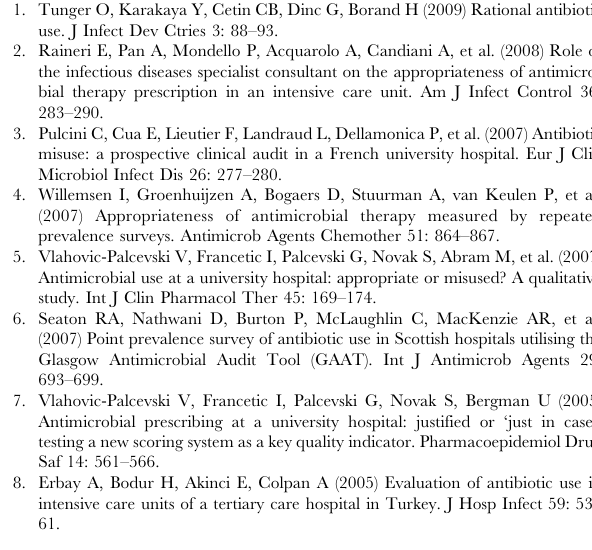
Table S1 Reported studies on evaluation of appropriateness of antimicrobial use between 2000 and